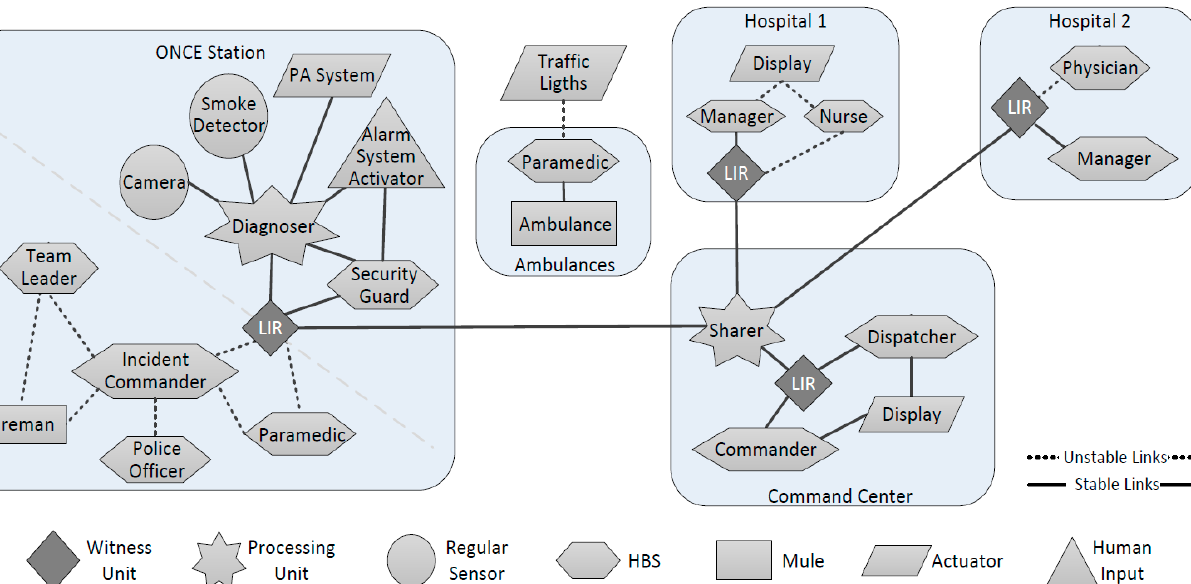
Figure 8. Model of a simple IoT-based system to support emergency response